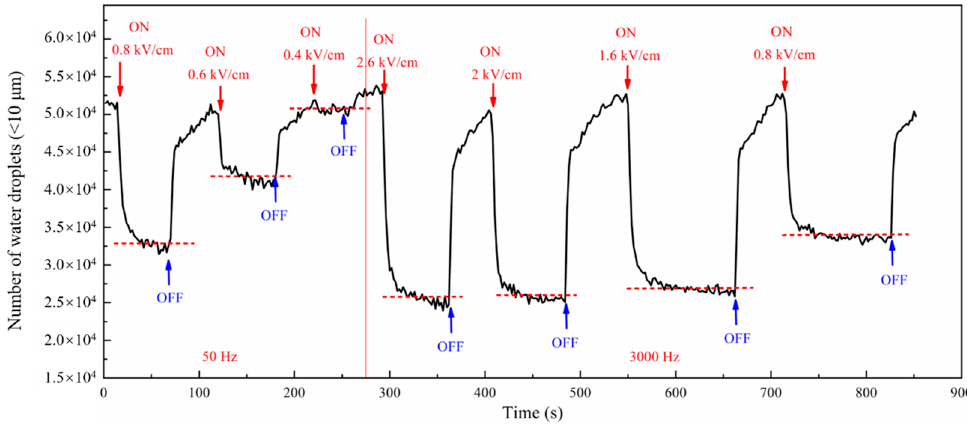
Figure 20. Variations of water droplets number within 10 μ m (water content 30%).